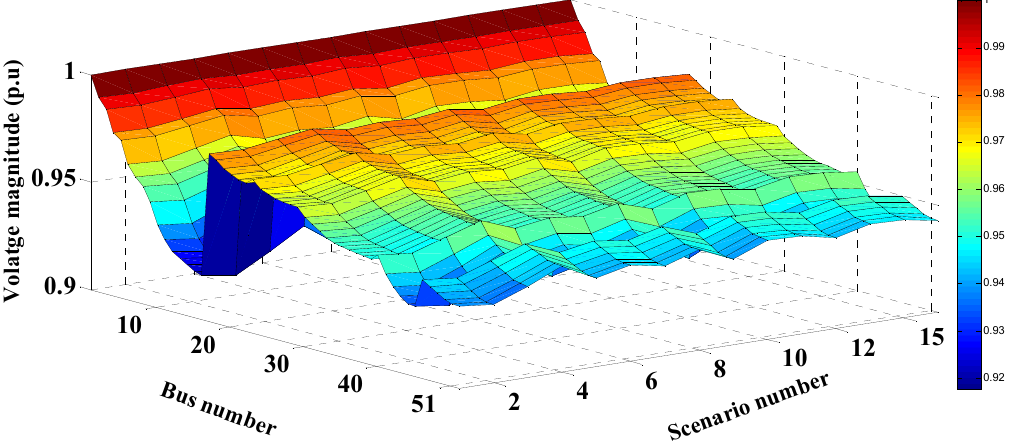
Figure 18. Bus voltage magnitudes of the 51-bus system without RERs.